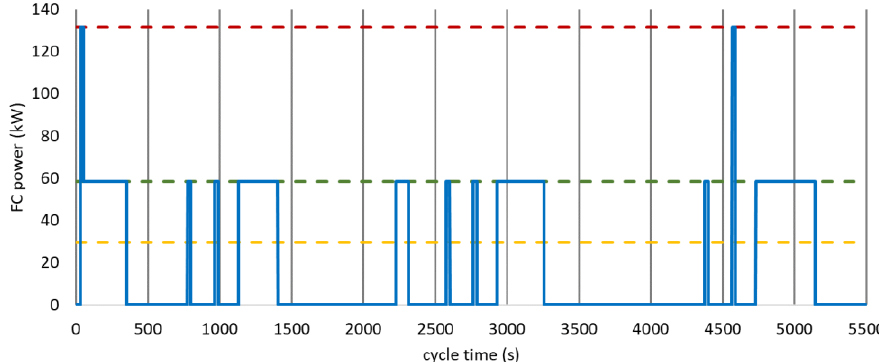
Figure 3. Example for the operation of the FCEV (truck light, hilly terrain, and WLTP triple-mixed drive cycle) (FC power = blue, FC max. power = red-dashed, FC optimal power = green-dashed, and FC min power = yellow-dashed).